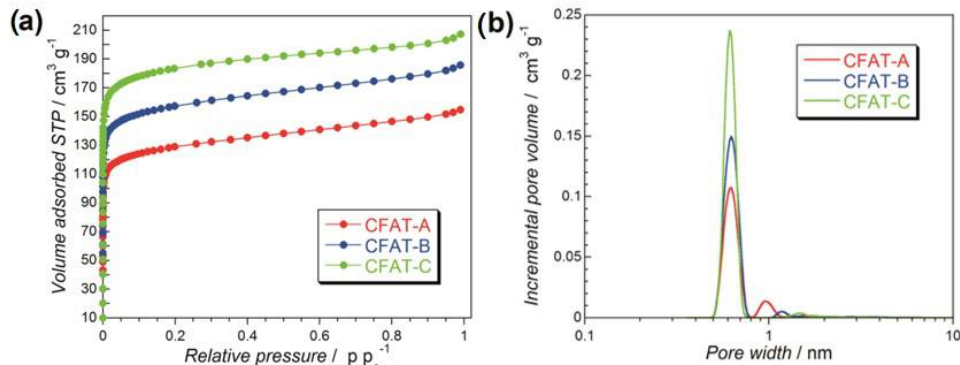
Figure 7. ( a ) Nitrogen adsorption isotherms and ( b ) pore size distributions for polyHIPE-derived carbons. Reprinted with permission from Ref. [53], Copyright 2016, American Chemical Society.